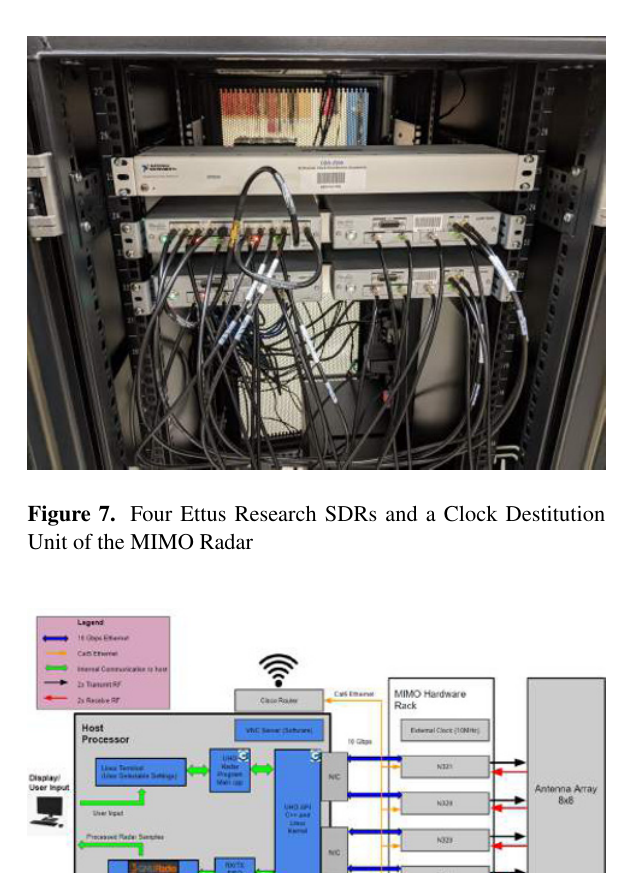
the 4 Ettus research SDRs, and the clock distribution